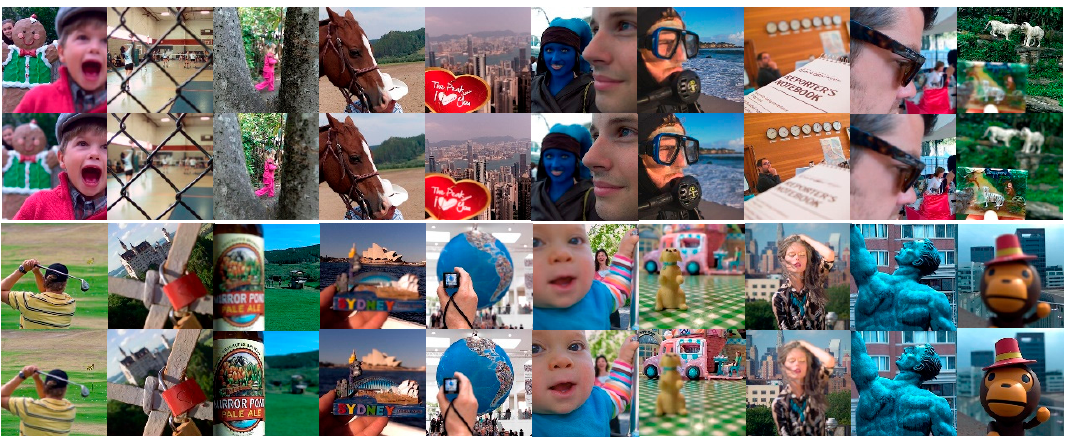
Figure 6. Eight pairs of popular multi-focus images.